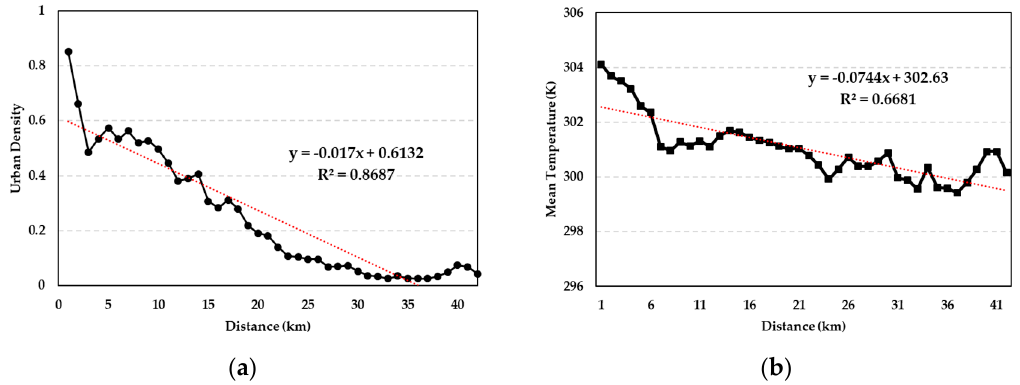
Figure 8. Trend analysis of ( a ) average urban density and ( b ) average temperature with distance from the city center.